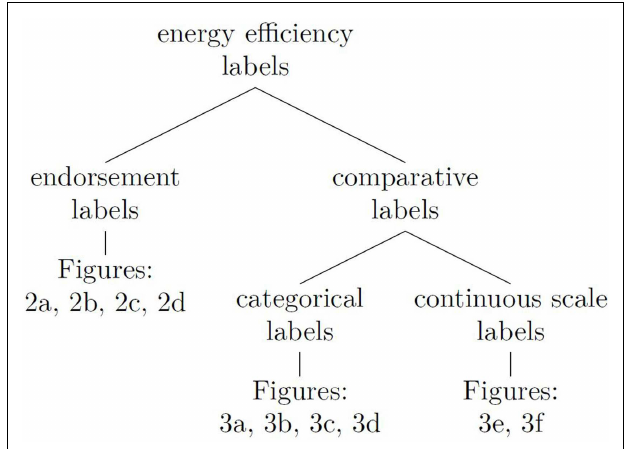
FIGURE 1 |Types of energy-efficiency labels